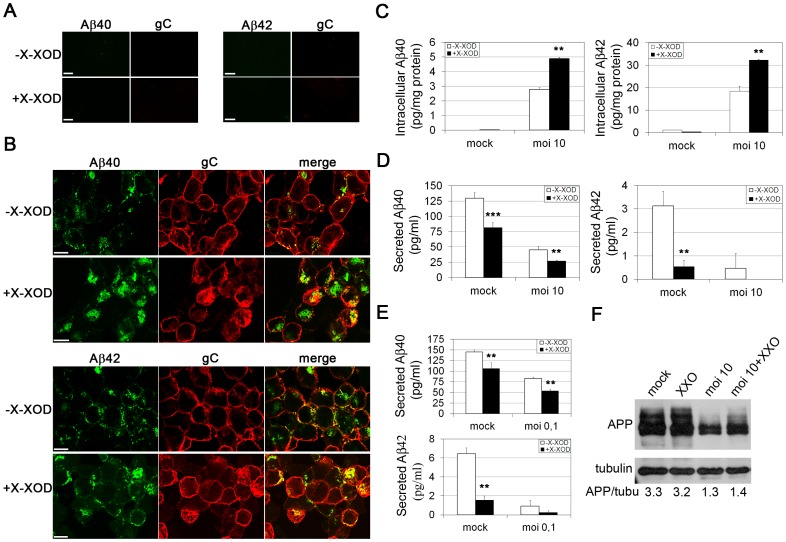
Effects of oxidative stress on Aβ levels in HSV-1-infected SK-APP cells.
A) Confocal microscopy images showing Aβ40, Aβ42 and gC immunoreactivities in SK-APP cells non-treated or treated with X-XOD for 18 h. Scale bar: 10 µm. B) Confocal microscopy images showing Aβ40 and Aβ42 immunoreactivities in cells infected with HSV-1 at a moi of 10 for 18 h (identified with an antibody that recognizes the glycoprotein C of HSV-1) in the presence and absence of X-XOD. Green (Aβ) and red (gC) channels were merged. Scale bar: 10 µm. C) ELISA analysis of intracellular Aβ levels, normalized by the amount of total protein, in HSV-1-infected cells at a moi of 10 for 18 h in the presence of X-XOD (**p<0.01). D and E) ELISA analysis of Aβ levels in the medium of cells treated with X-XOD and infected with HSV-1 at a moi of 10 for 18 h (D) or 0.1 for 42 h (E) (**p<0.01; ***p<0.001). In (C-E) the results are the means of at least four experiments. Bars show the SEM. F) Analysis of APP levels by Western blotting in SK-N-MC cells infected with HSV-1 at a moi of 10 for 18 h. The effect of X-XOD is shown. A control ensuring equal loading - a tubulin blot - is also shown. The ratio of APP to tubulin is shown below the blots. The blots are representative of four independent experiments.